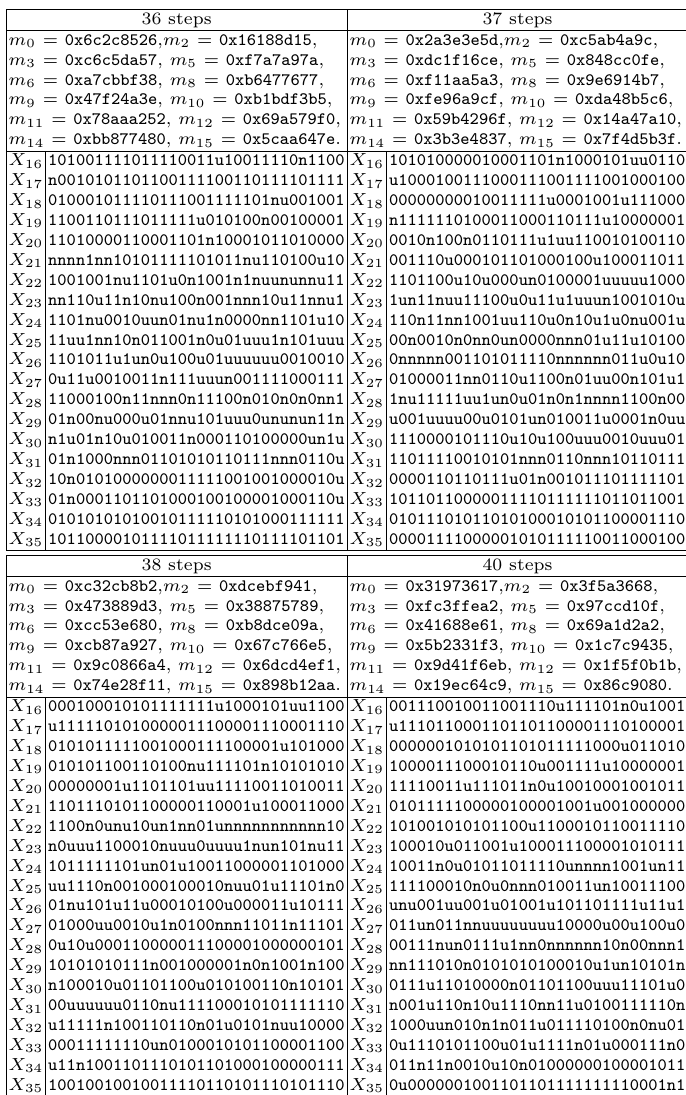
Table 4: Solution for X i (16 ≤ i ≤